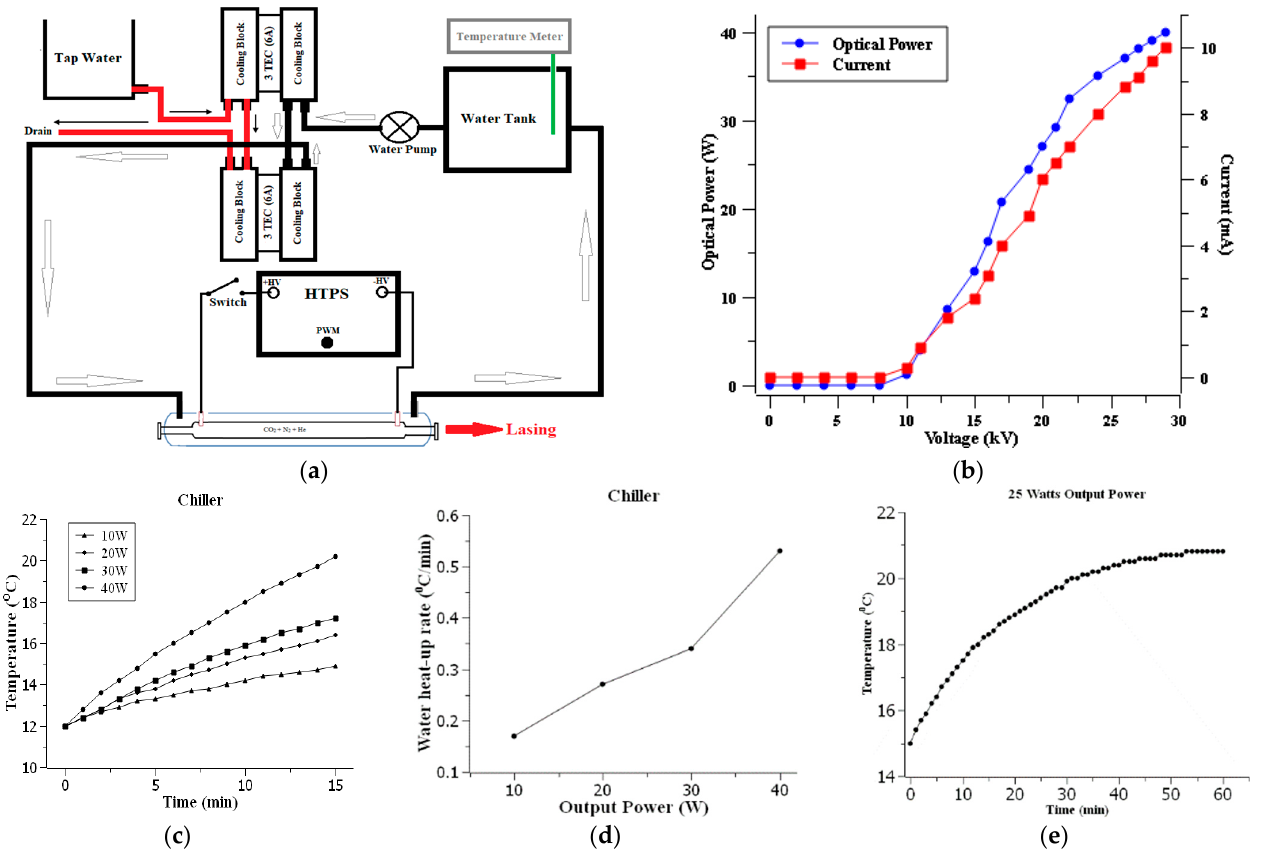
Figure 3. ( a ) Complete laser system with cooling system and high-tension pump source connections. ( b ) Variation of laser output power and current along applied voltage. ( c ) Variation in water temperature circulating in the tube along output power of the laser. ( d ) Output power vs. water heat-up rate. ( e ) Chiller behavior at a moderate output power for an extended period of operation.